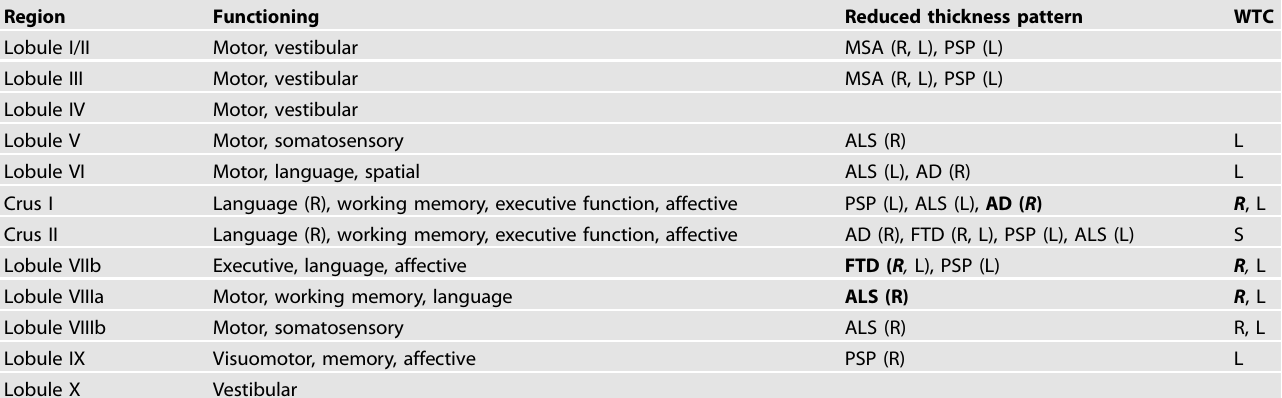
Hemispheric results are listed using L for left and R for right. Boldface cortical thickness patterns denote results that overlap with WTC-related regions shown in the rightmost column. WTC patterns that were nominally signi fi cant are listed, while regions that passed the false discovery rate. MSA multiple system atrophy, PSP progressive supranuclear palsy, ALS amyotrophic lateral sclerosis, AD Alzheimer ’ s disease, FTD frontotemporal dementia, WTC World Trade Center